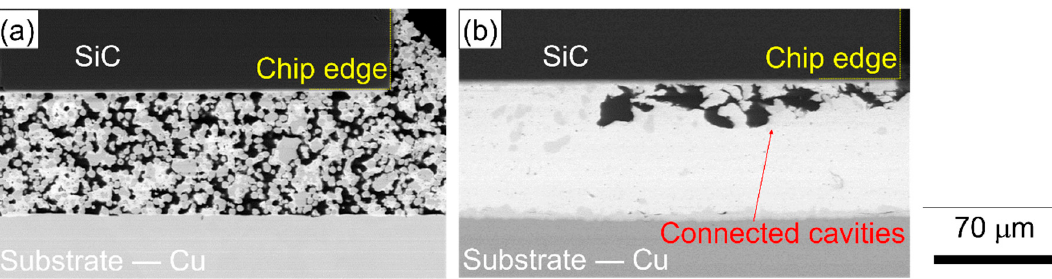
Figure 8. Cross-sectional SEM image of ( a ) the TLPS joint after 1,200 thermal cycles and ( b ) the SAC305 joint after 600 thermal cycles in the temperature range of –55 to 175 °C.